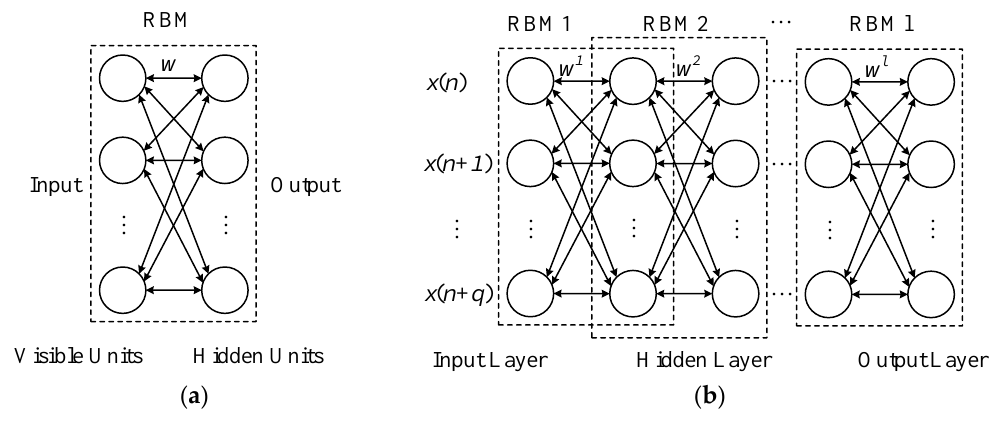
Figure 1. Structural illustration: ( a ) RBM structure; and ( b ) DBN structure.